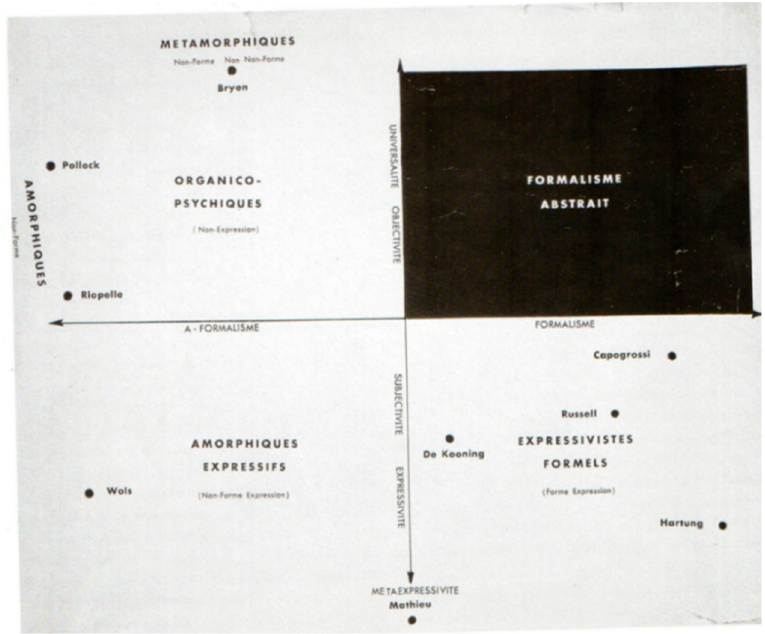
Figure 9. Flyer for the exhibit Véhémences confrontées , gallery Nina Dausset, 8–31 March 1951. Archives Camille Bryen. Courtesy Fondation de France.